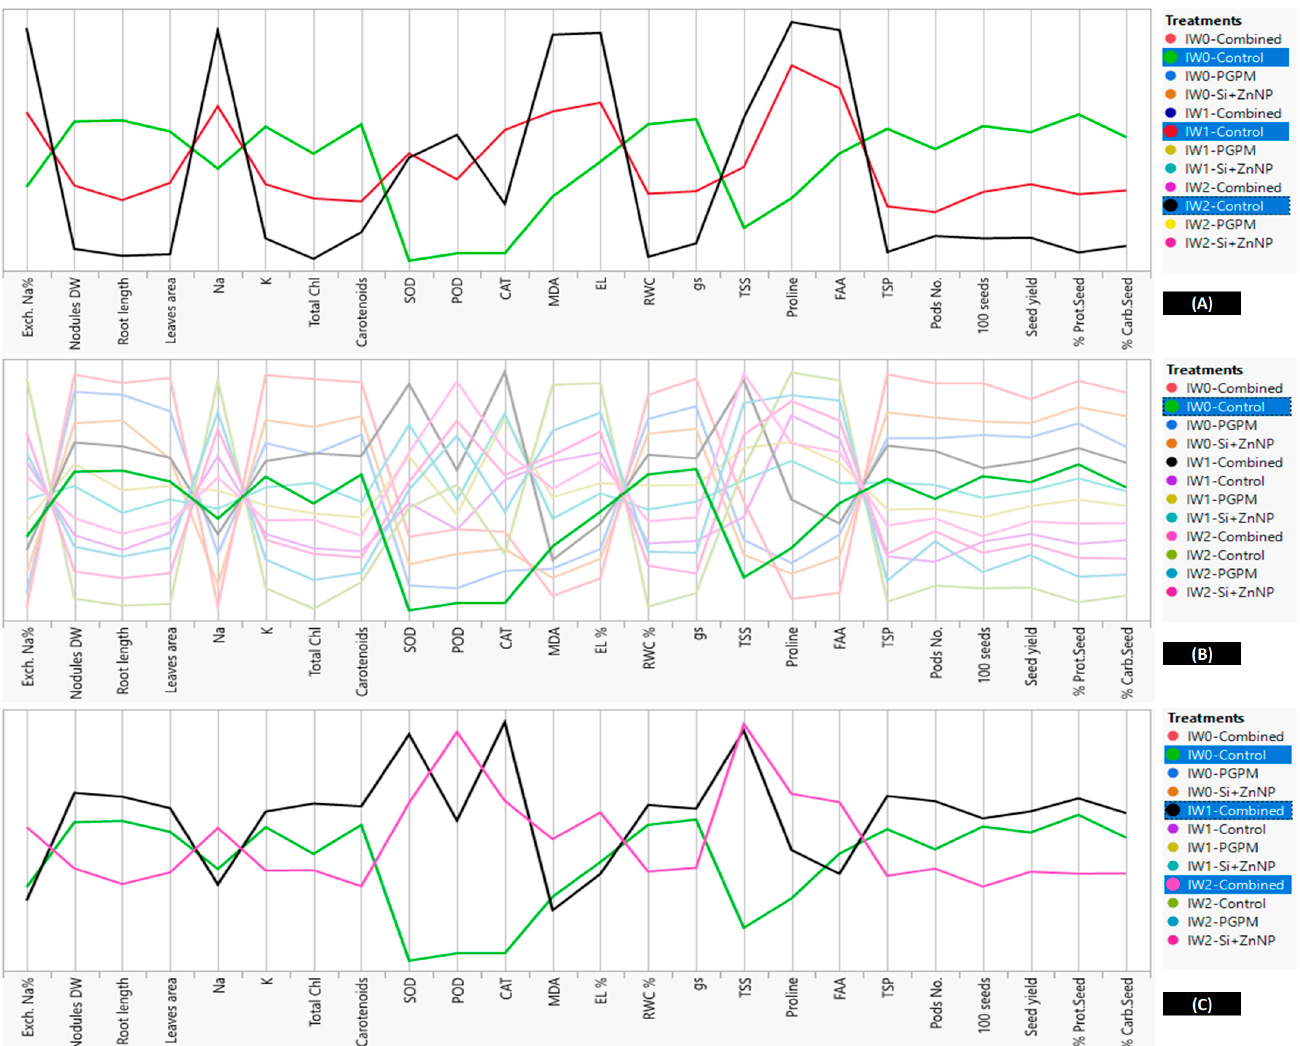
Figure 9. Parallel coordinates comparison plot showing how soybean studied variables changes in relation to the changes in irrigation levels, ( A ) comparison between controls under different intervals of watering, ( B ) comparison between all treatments in regard to the control of well watering as a reference, ( C ) comparison between the effect dual application of PGPMs and Si-ZnNPs under the higher levels of deficit irrigation in regard to control of well watering as a reference.